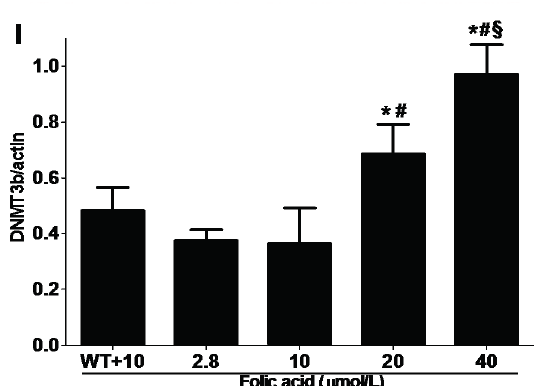
Figure 4. Folic acid increases the expression of DNMT isoforms in N2a cells. Wild type N2a cells were incubated with 10 μ mol/L folic acid (WT + 10) and N2a-APP cells were incubated with 2.8–40 μ mol/L folic acid for 96 h. ( A – C ) Gene expression levels of DNMT1 , DNMT3a and DNMT3b in N2a and N2a-APP cells ( n = 3 experiments); ( D – F